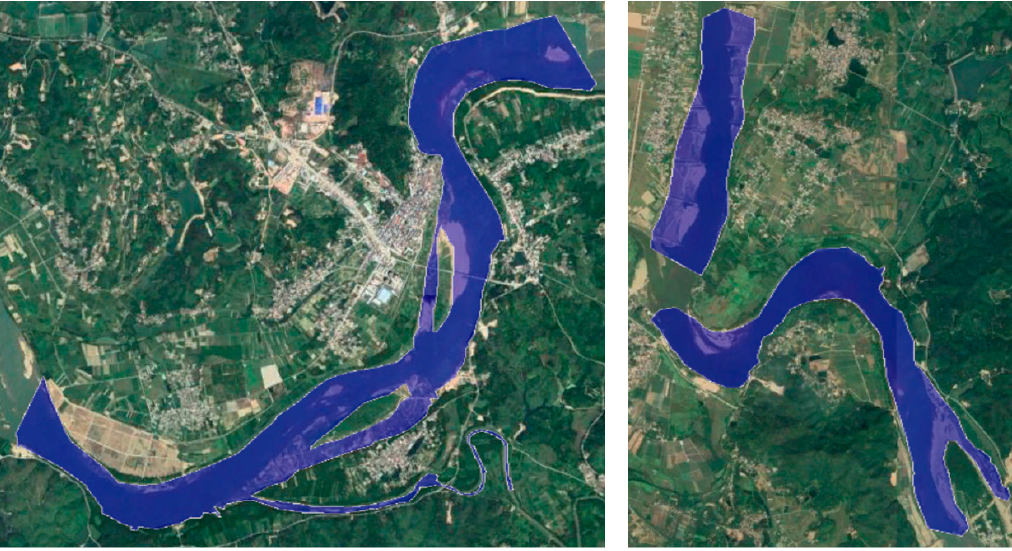
Figure 7. Flood map overlaid on a Google Earth image.